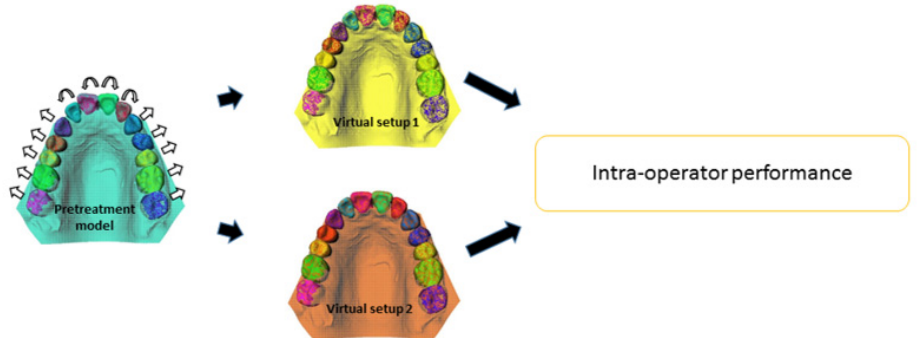
Figure 3. During the fabrication of the orthodontic setup, all individual segmented tooth crowns, displayed in different colors, can be moved in any direction, as shown by the white arrows. This procedure is repeated by the same operator a second time. The tooth movements of the first and second setups are subsequently compared to assess the intra-operator performance.